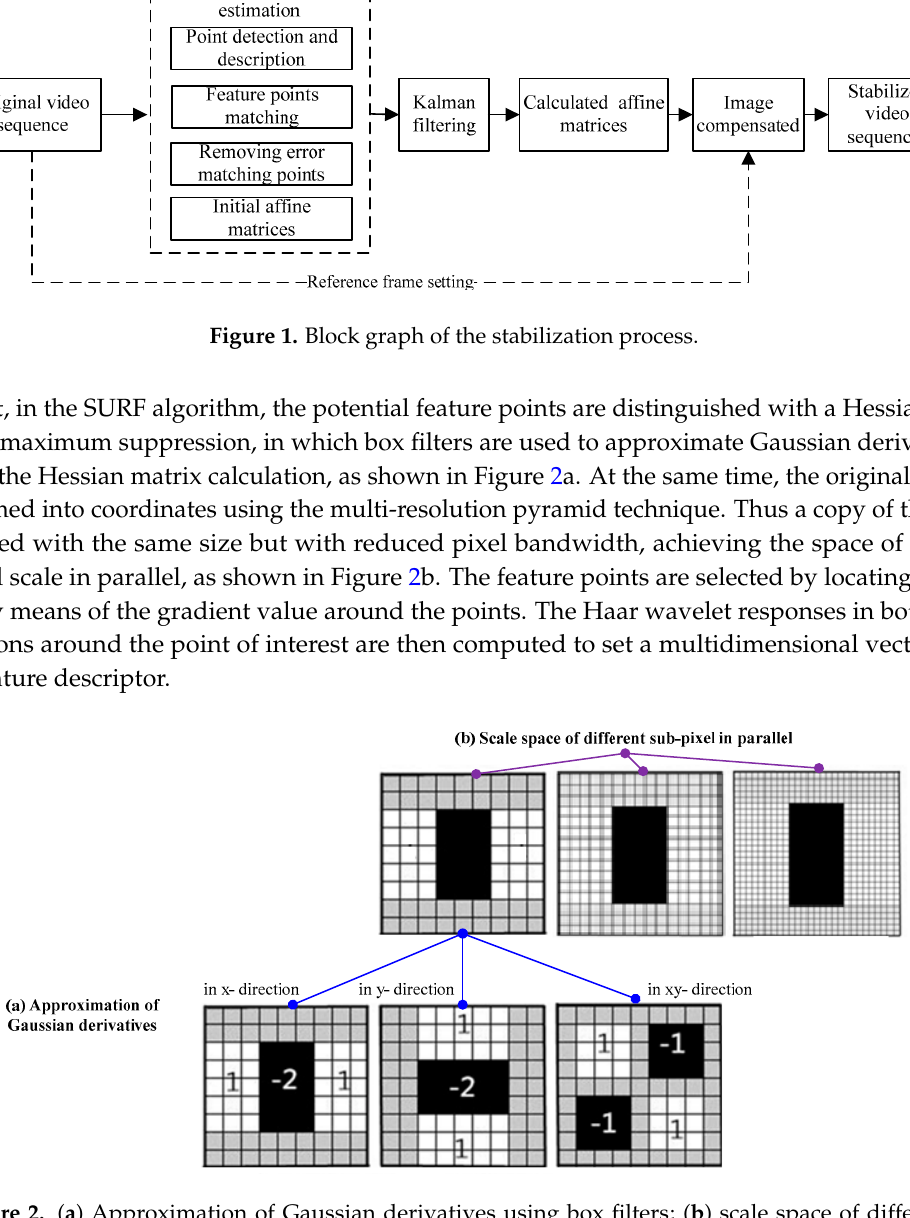
Figure 2. ( a ) Approximation of Gaussian derivatives using box filters; ( b ) scale space of different sub-pixels in parallel.